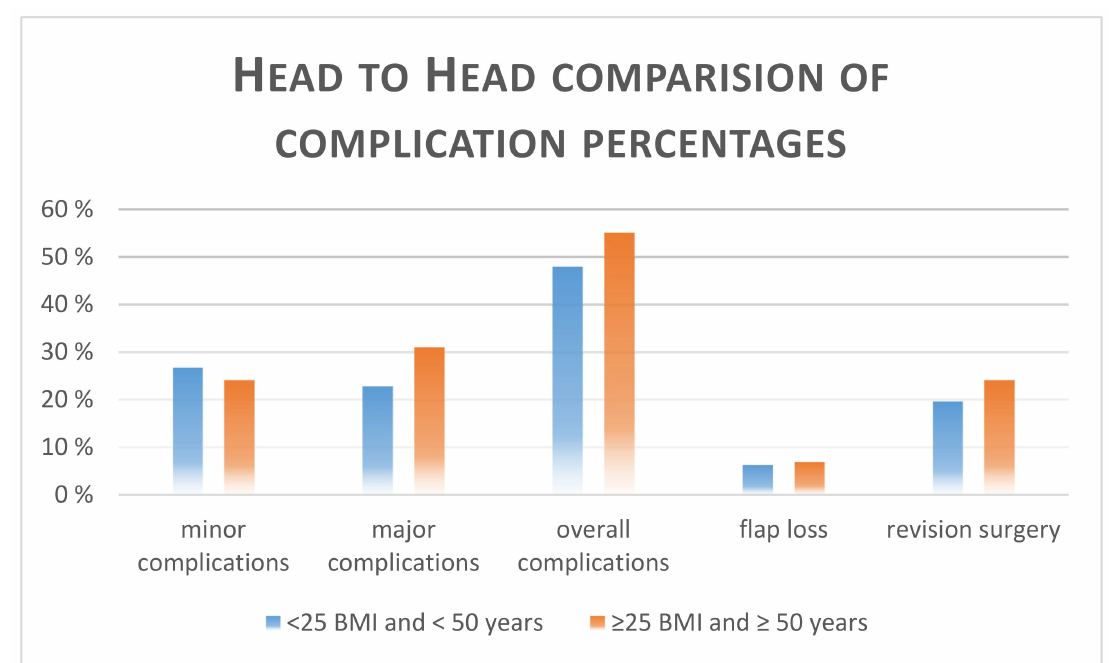
Figure 5. Schematic illustration of Table 4, comparison of patients with higher BMI and over 50 years to younger patients with lower